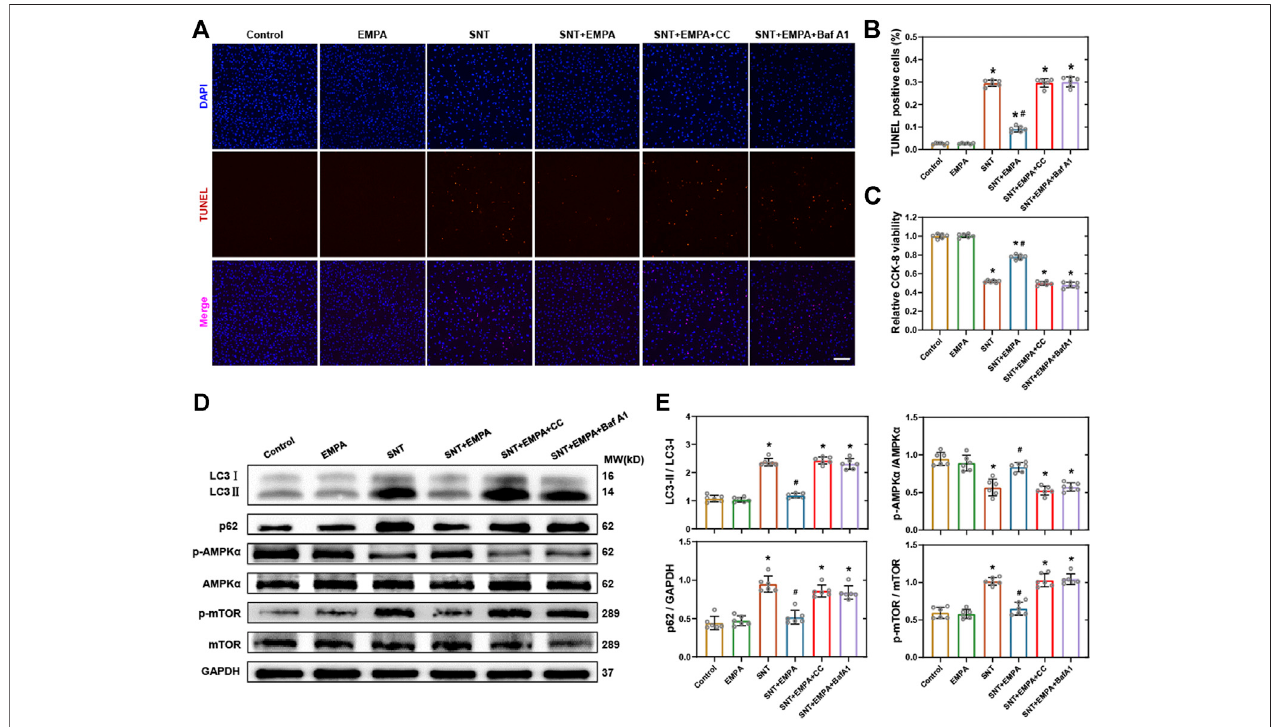
FIGURE 7 | Inhibition of AMPK or autophagy-blocked EMPA-conferred protection against SNT-induced cardiotoxicity in cardiomyocytes. (A) Representative images of TUNEL positive cells in H9c2 cardiomyocytes treated by vehicle, EMPA, SNT, or SNT plus EMPA in combination with or without AMPK inhibitor compound C (CC) or autophagy inhibitor (Baf A1). (B) Statistical analysis among different groups, n (cid:1) 6 per group, bar (cid:1) 100 μ m. (C) CCK-8 viability assay of H9c2 cardiomyocytes amongdifferentgroupsmentioned above, n (cid:1) 6pergroup. (D) RepresentativeWesternblotsoftheAMPK – mTOR – mediatedautophagypathway. (E) Protein-level quanti fi cations ofLC3-II toLC3-I, p62 toGAPDH, phosphorylatedAMPK tototal AMPK, and phosphorylated mTOR tototal mTOR ratios, n (cid:1) 6per group. * p < 0.05vs. control, # p < 0.05 vs.